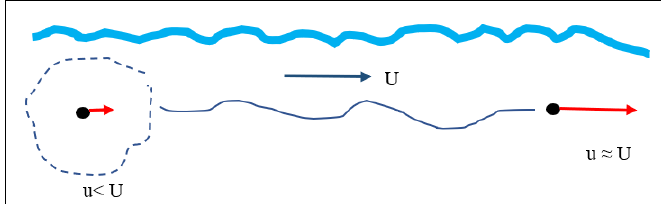
Figure 4: Retardant effect of the ionic atmosphere by the Einstein- Stokes effect.